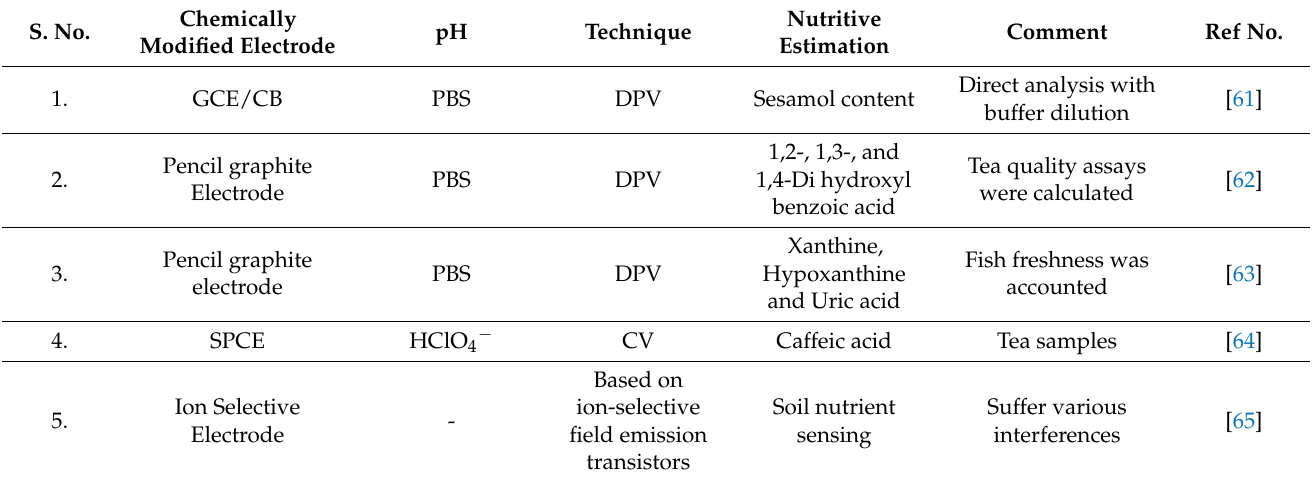
Table 3. Tabulation of various sensors used for the nutritive estimation by various